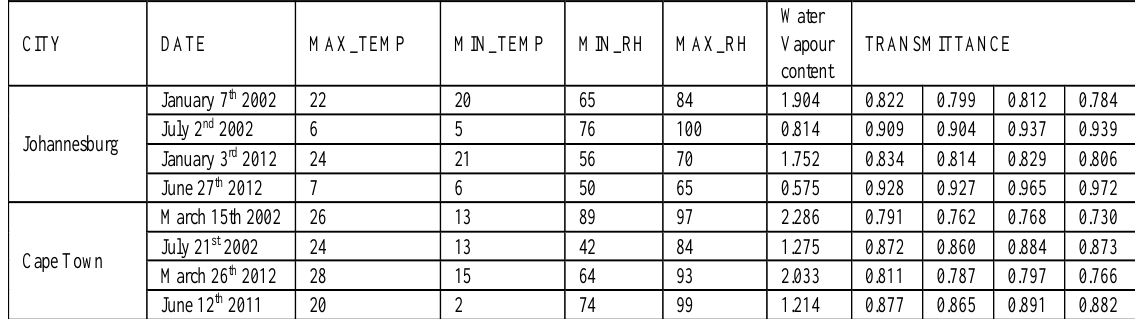
Table 1: Satellite and auxiliary data collected and estimated parameters (water vapour content and transmittance)